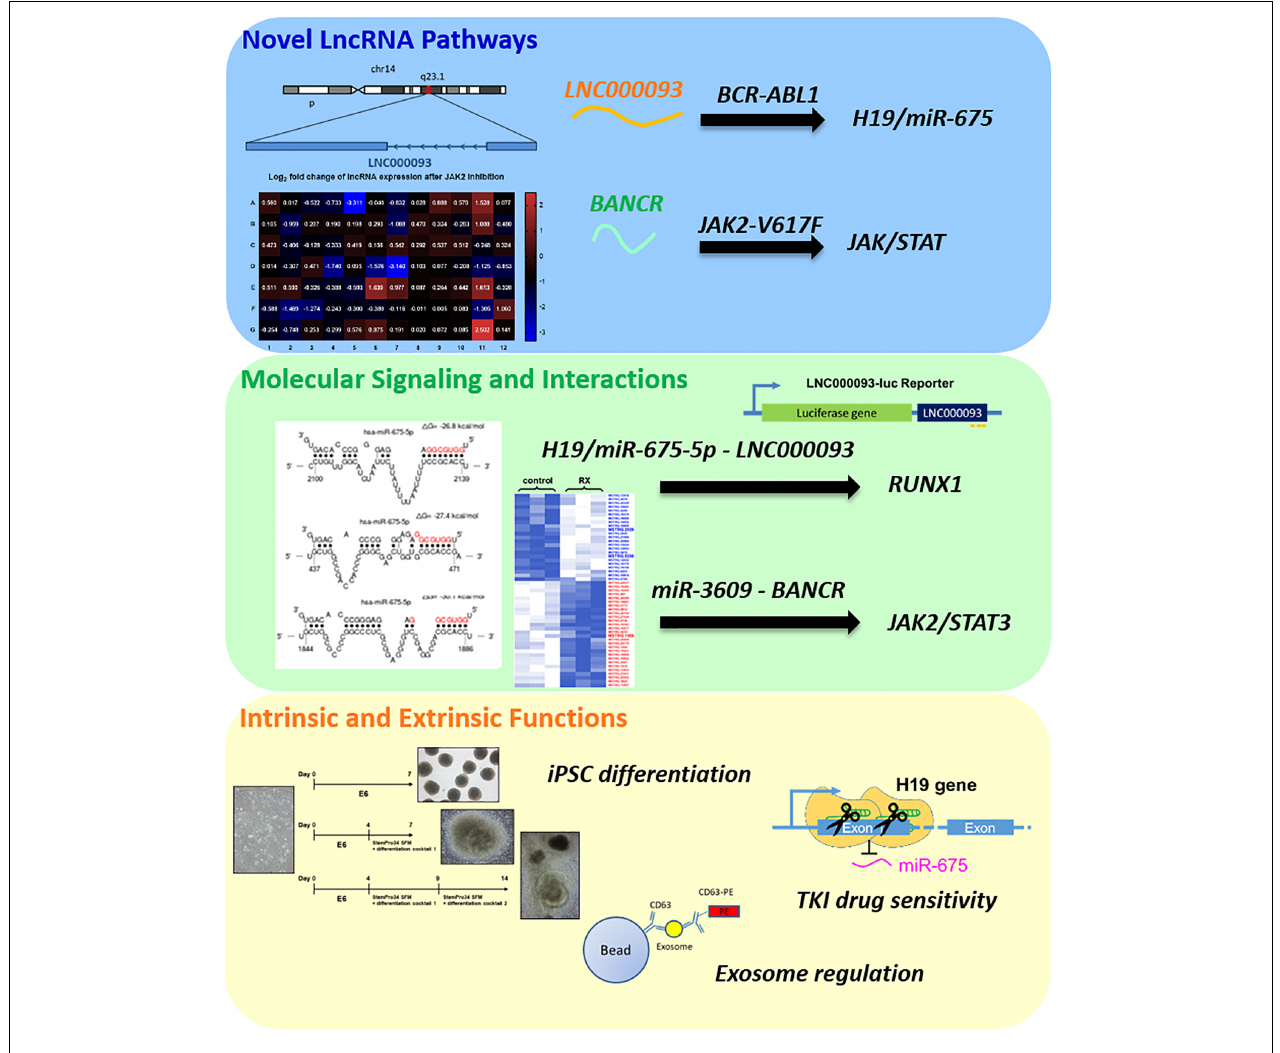
FIGURE 7 | A summary of newly identified CML- and MPN-associated lncRNAs and their putative regulatory role.